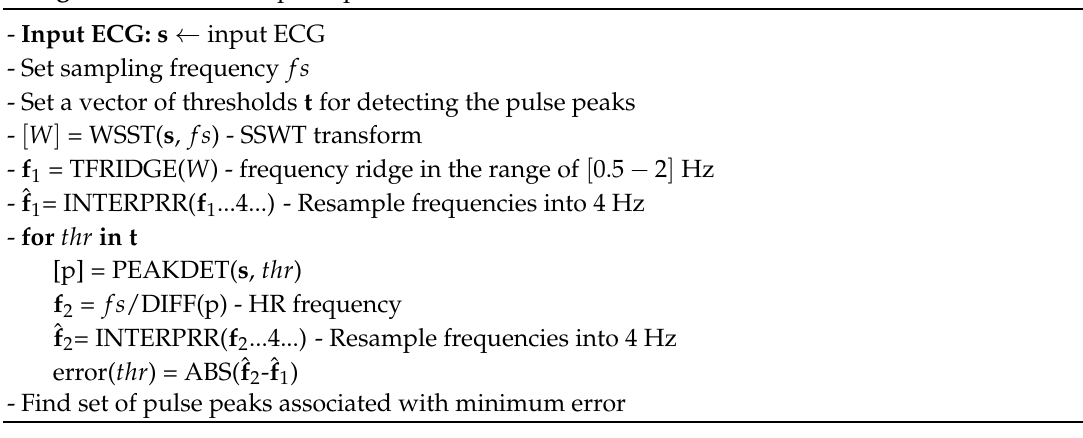
Algorithm 1: Iterative pulse peak detection.